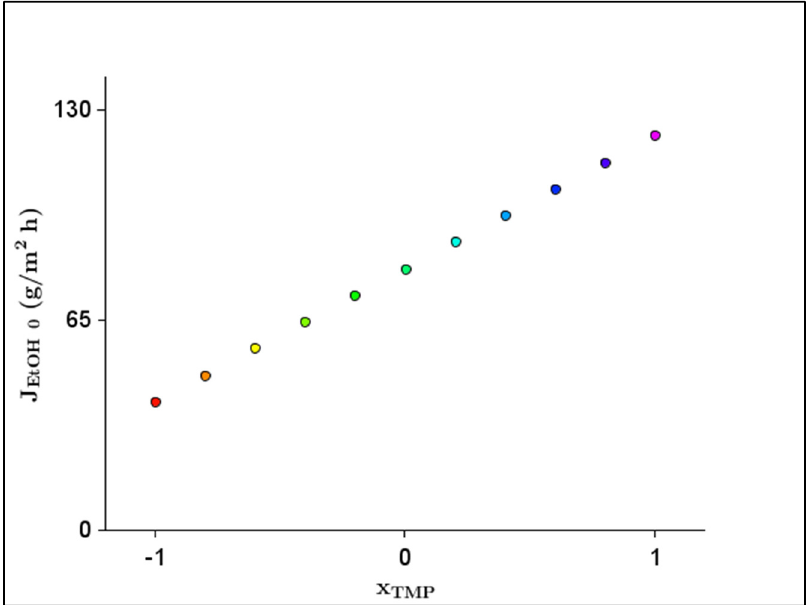
Figure 4. Two-dimensional response plot of the effect of significant parameter (transmembrane pressure– x TMP ) for initial ethanol flux ( J EtOH 0 ). The optimal value of the factor amounted to TMP = 30 bar, considering the ethanol flux. The predicted J EtOH 0 under the above condition was 121.965 g/m 2 h. Therefore, the highest J EtOH 0 could be achieved with the highest